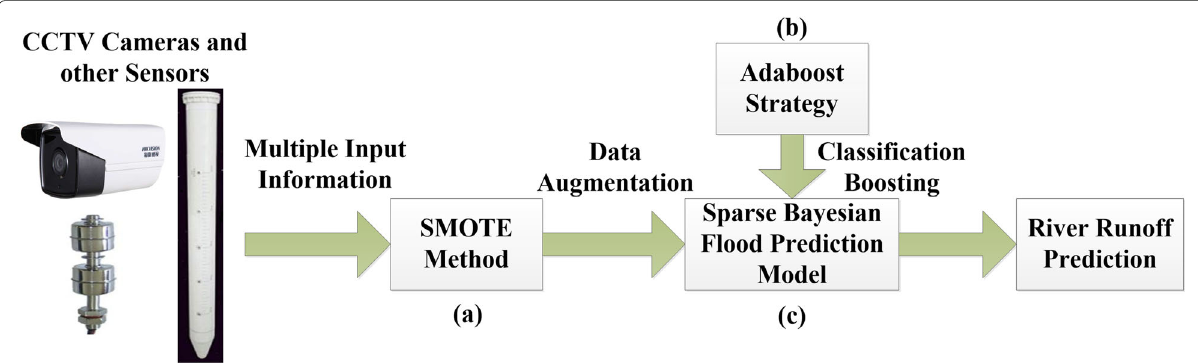
Fig. 1 Workflow of the proposed model for river runoff prediction. Detailed legend: Fig. 1 shows the workflow of the proposed model, which consists of three modules, namely, SMOTE method, AdaBoost Strategy, and Sparse Bayesian Flood Prediction Model. A SMOTE method ( a ) is used to generate virtual samples for data augmentation, which solves the problem of imbalanced flood data to a certain extent. After pre-processing original data by SMOTE method, we adopt a novel AdaBoost strategy ( b ) to train multiple Bayesian models to obtain an improved and integrated model. Afterwards, the Sparse Bayesian Flood Prediction Model ( c ), where the proposed sparse Bayesian model improves the original Bayesian model by offering a probability distribution constraint to weights of iteration training model. With all these steps, we build a complete workflow of a data-driven model to predict river runoffs with high accuracy and